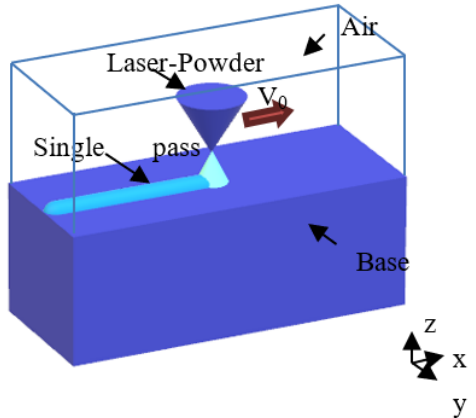
Figure 1. A schematic of coaxial powder feeding additive manufacturing.